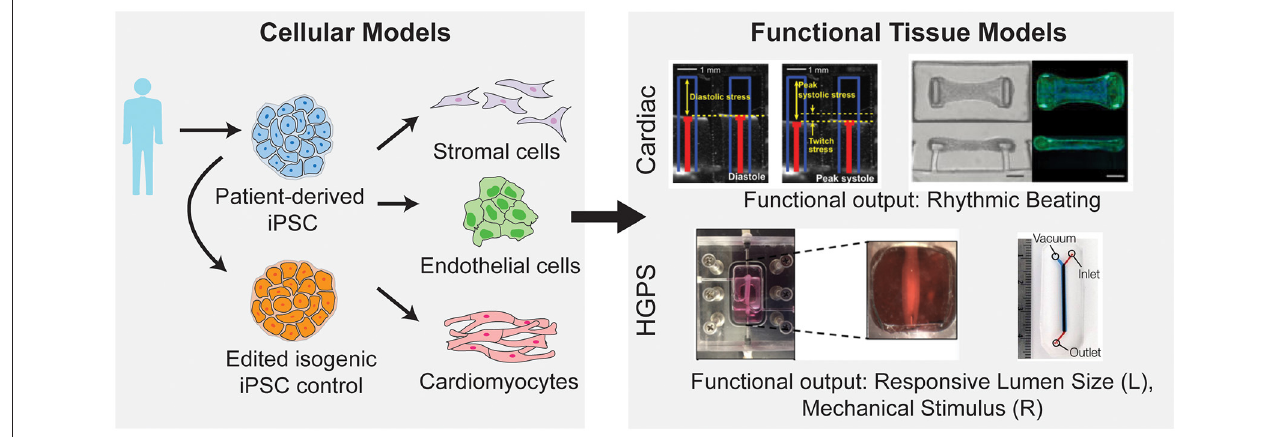
FIGURE 4 | Integration of patient derived iPSC with microfluidic models to study cardiovascular diseases. iPSCs can be generated from patient cells and subsequently differentiated into a variety of vascular cell types. Further these iPSCs can be genetically mutated to create an isogenic control cell line to preserve the genetic background of the patient but erase the mutation of interest (left). After differentiation into vascular cells, these cells can be used in microfluidic disease models of both cardiac and vascular diseases (right). By utilizing microfluidic systems, the disease model can incorporate functional outputs as indicated [top, right; image on the left reprinted by permission from Springer Nature Customer Service Centre GmbH: Springer Nature, Wang et al. (2014), Copyright 2014. Image on the right from Hinson et al. (2015). Reprinted with permission from AAAS. Bottom, right; image on the left reproduced from Atchison et al. (CC by 4.0: http://creativecommons.org/ licenses/by/4.0/). Image on the right reprinted with permission from John Wiley and Sons from Ribas et al. (2017), Copyright 2017 WILEY-VCH Verlag GmbH & Co. KGaA, Weinheim].